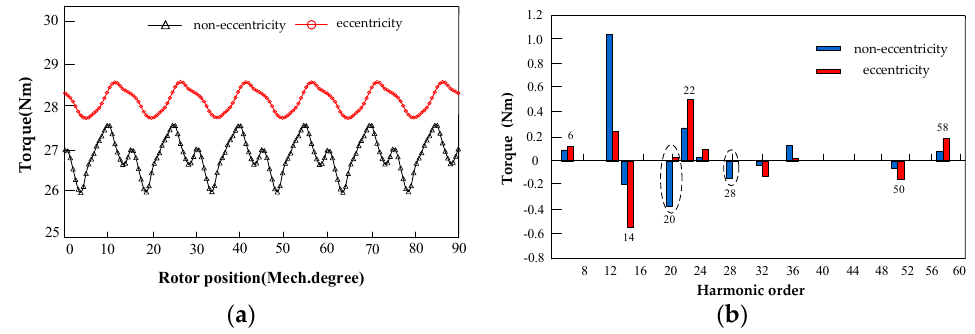
Figure 11. The electromagnetic torque generated by air-gap magnetic density harmonics: ( a ) the torque generated by the fundamental component and ( b ) the torque generated by the remaining harmonics.